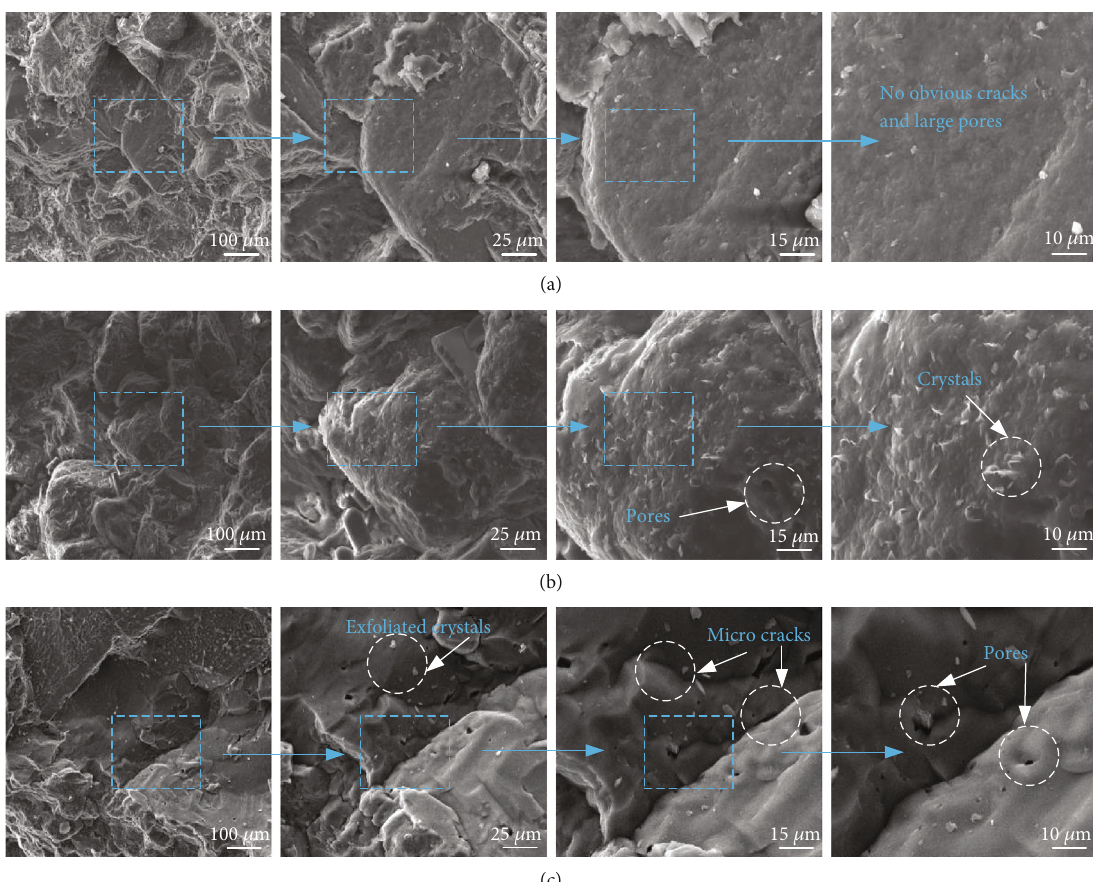
Figure 7: Scanning electron microscopy image of red sandstone surface before and after heat treatment.